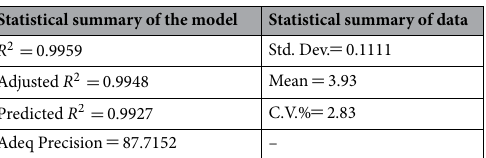
Table 13. The descriptive statistics of the proposed model for Merkel number using MWCNTs nanofluid.